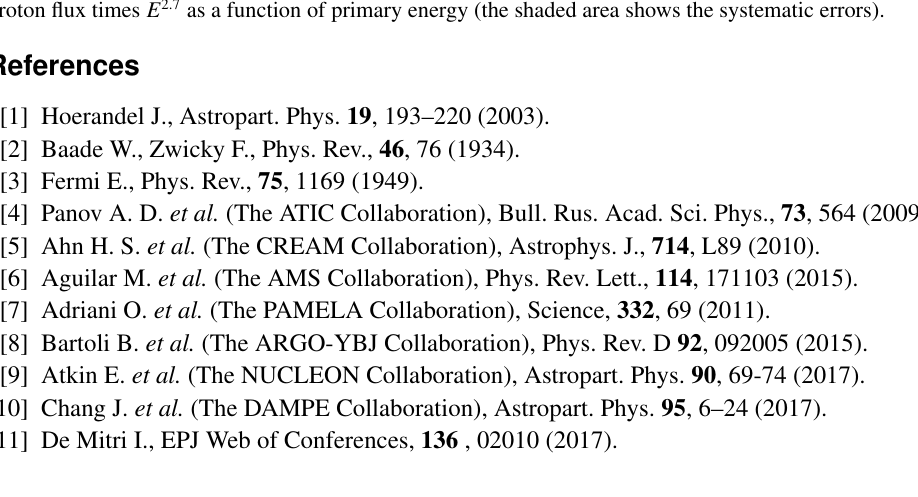
Figure 4. Left - The e ff ective acceptance of protons as a function of primary energy. Right - The preliminary proton flux times E 2 . 7 as a function of primary energy (the shaded area shows the systematic